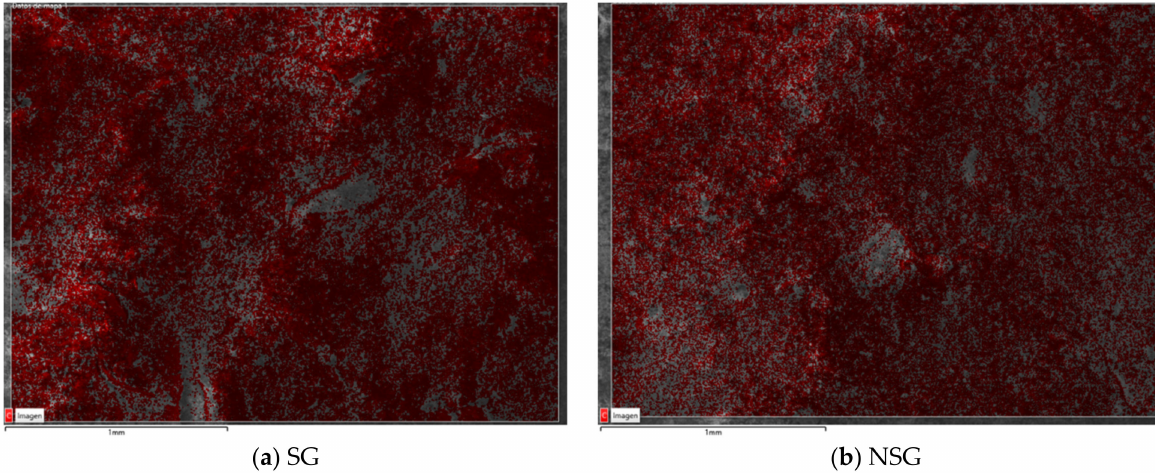
Figure 6. Secondary electron image of mapping carbon element of SG ( a ) and NSG ( b ) after Karsten tube